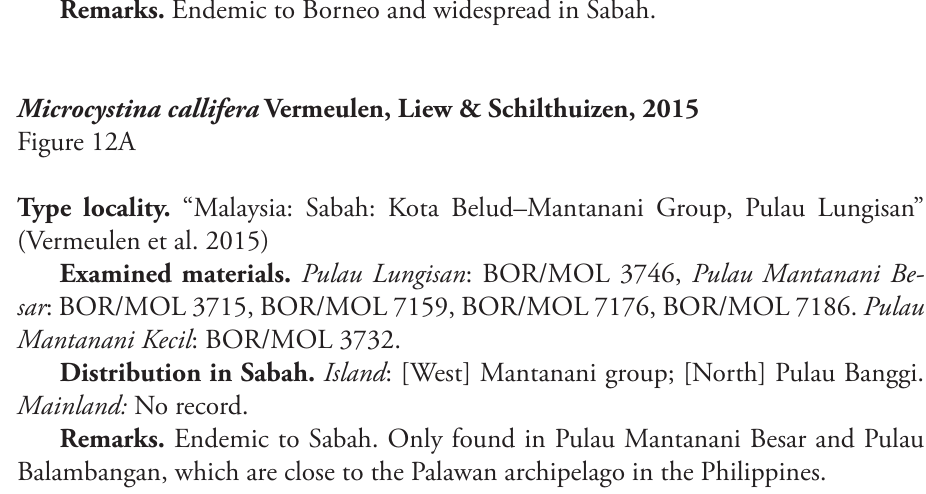
Type locality. “Indonesia: North Sumatra: Karo Regency–Berastagi” (van Benthem Jutting